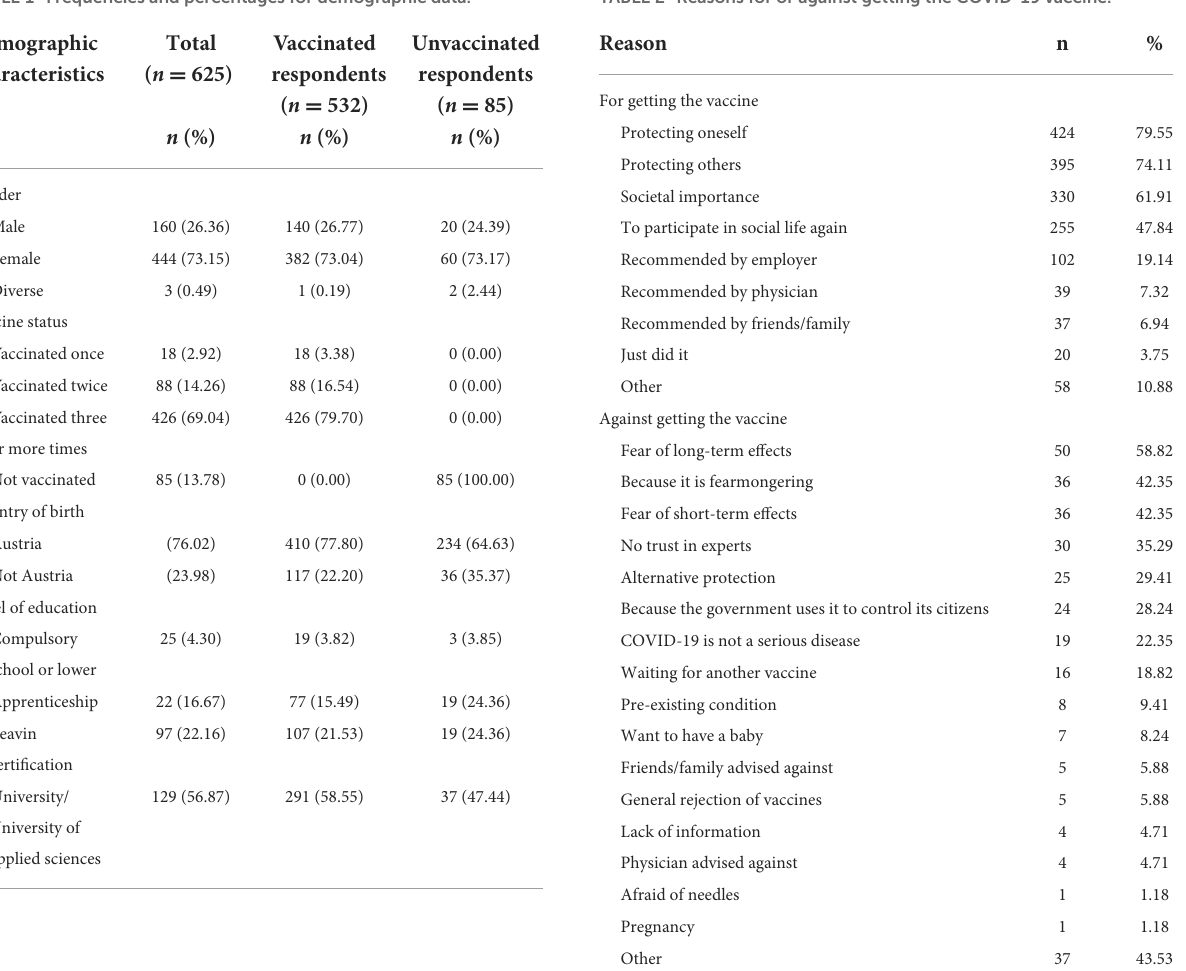
TABLE 1 Frequencies and percentages for demographic